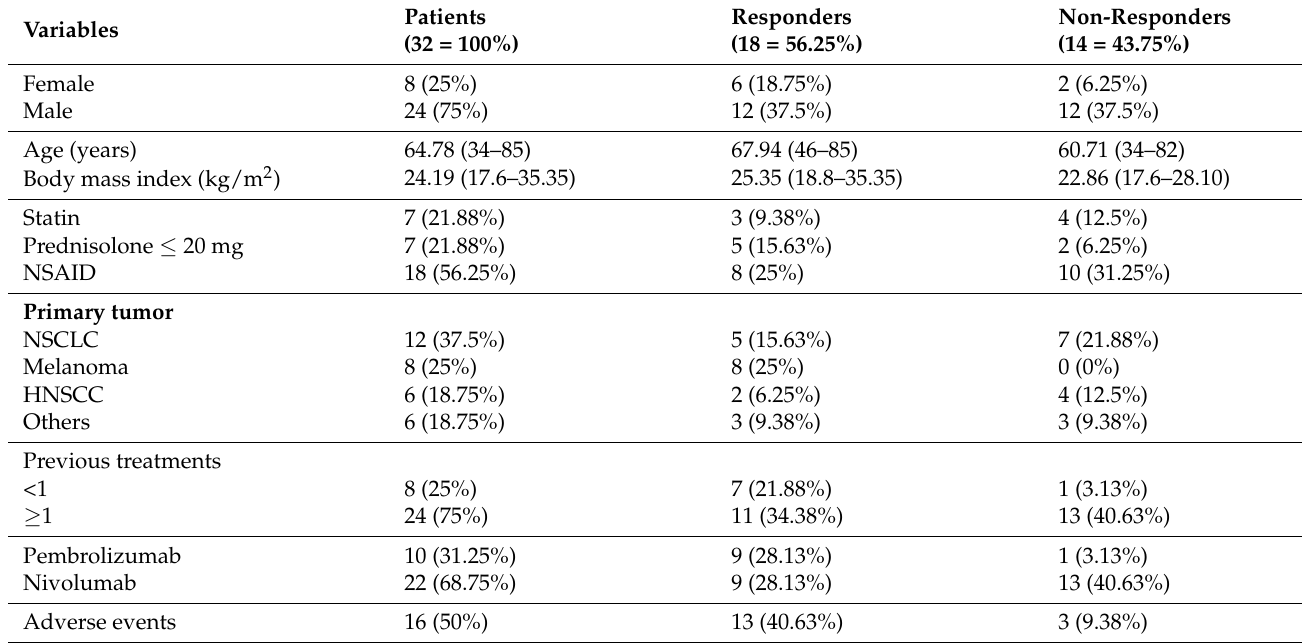
Table 1. Overview of patient